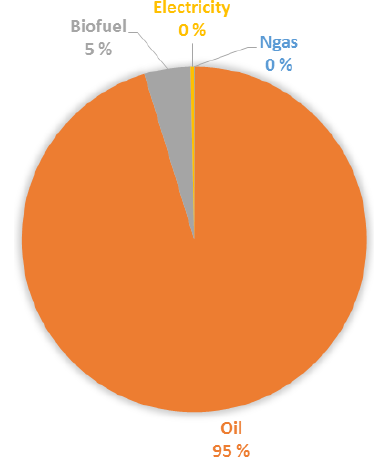
Figure 16. Fuel consumption for transport in Finland.